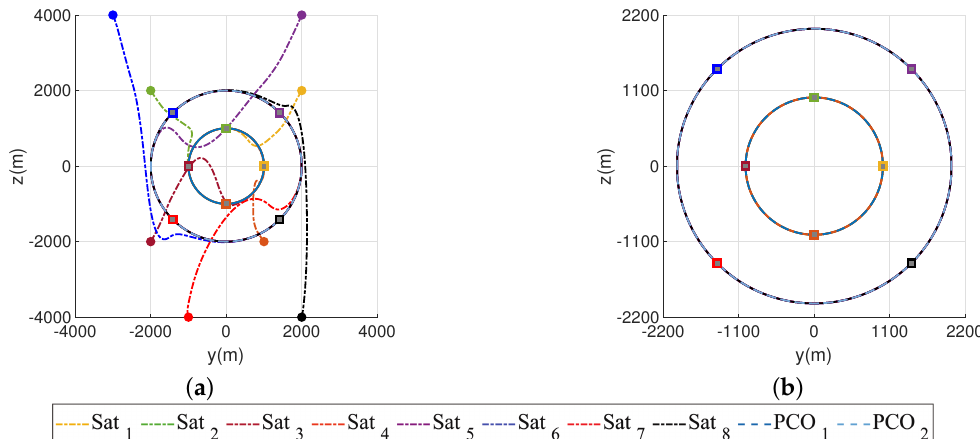
Figure 8. PDC law. Trajectories’ plots: ( a ) on plane YZ; ( b ) on plane YZ after orbiting.